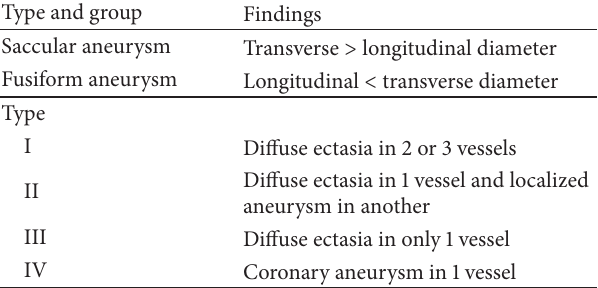
Table 2: Group and type of dilatation of coronary arteries. Type and